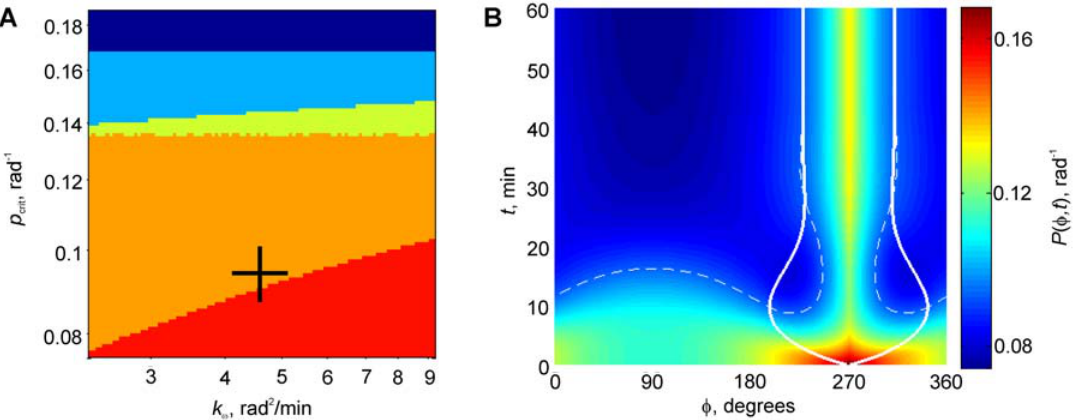
Figure 2. Model behavior when the TCR recycling point coincides with the APC contact initiation point. ( A ) Domains of the parameter space that determine qualitatively different dynamic scenarios. On the axes, p crit is the critical TCR density for attachment to the APC, and k v is the rate constant of the contact expansion. Other parameters values are as measured experimentally. Dark-blue , no contact develops; light-blue , a stable contact develops that is insignificant in size ( , 30 u arc); yellow , contact collapses incompletely after exceeding 30 u arc transiently; orange , contact stabilizes above 30 u arc; red , infeasible expansion . 180 u is predicted. Cross denotes the parameter combination for the dynamic example shown in panel B : p crit =0.09 rad –1 , k v =4.7 rad 2 /min. ( B ) Dynamics of the surface TCR distribution P ( w , t ) and contact boundaries w 1,2 ( t ). TCR density P is color-coded in the units of the fraction of the total amount of TCR in the cell per radian of the cell circumference. Solid lines give the position of the contact boundaries w 1 , w 2 . Dashed line is the isoline of the critical TCR density for contact expansion, P = p crit . w is the angular coordinate around the TC, with 270 u corresponding to the bottom of the cell where the recycling is assumed to be directed and where the contact with the TCR-binding substrate is initialized in our experiments. t is time after the contact initiation (therefore a horizontal line through the plot gives an instantaneous distribution of TCR and the positions of the contact boundaries at the time corresponding to the height at which the imaginary line is drawn).